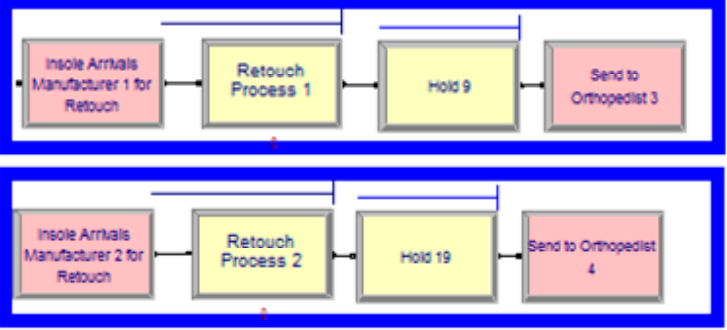
Figure 10. First testing of insole and adjustments in the office of orthopedist.